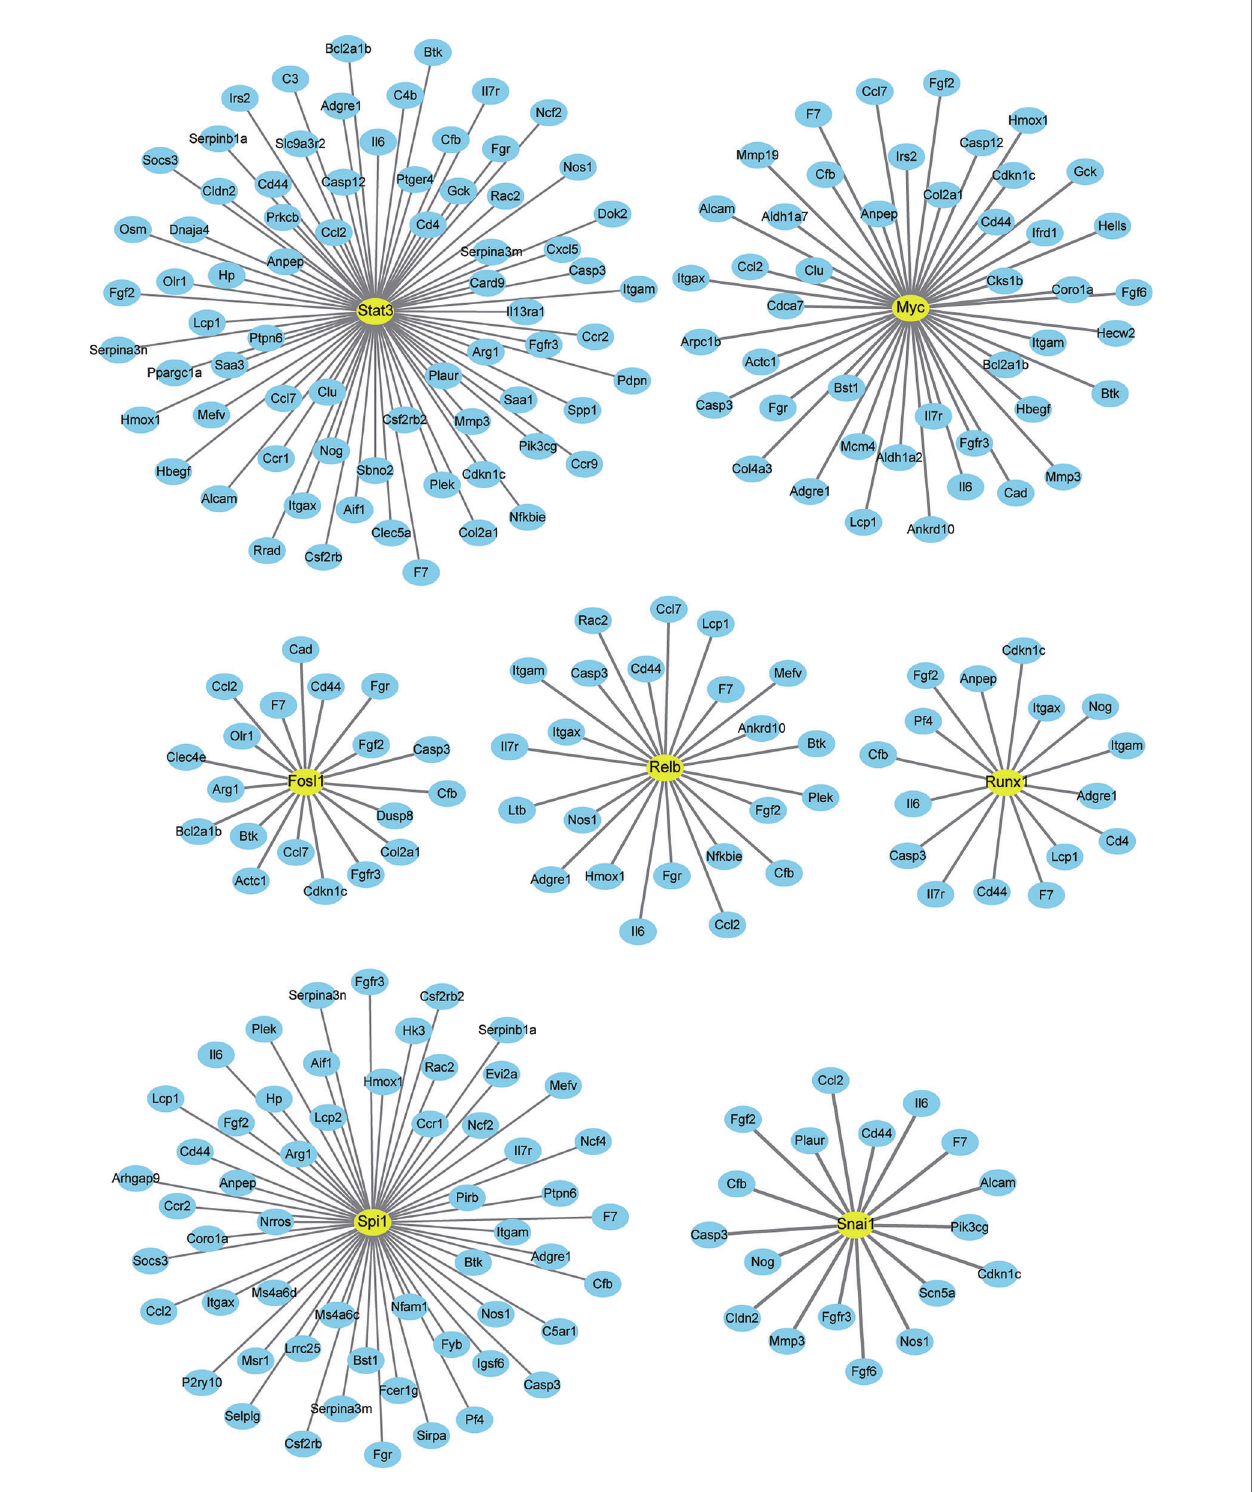
FIGURE 7 | Interaction between differentially expressed genes (DEGs) and differentially expressed transcription factors co-expressed after one and three days of interleukin-6 (IL-6) infusion. All transcription factors (TFs) and DEGs co-differentially expressed after one and three days of IL-6 infusion are integrated and analyzed. Several representative TFs that interacted strongly with IL-6 are labeled. Only TFs and DEGs with a score > 200 for the interaction are